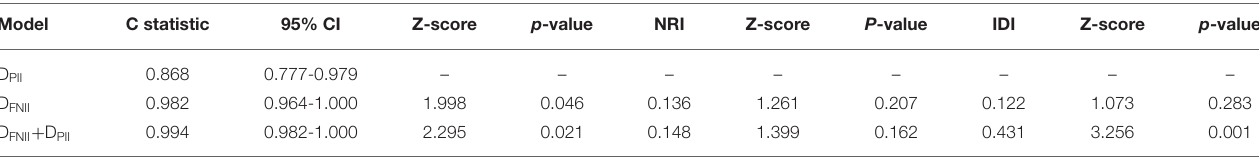
TABLE 3 | Differences of predictive performances of each model.